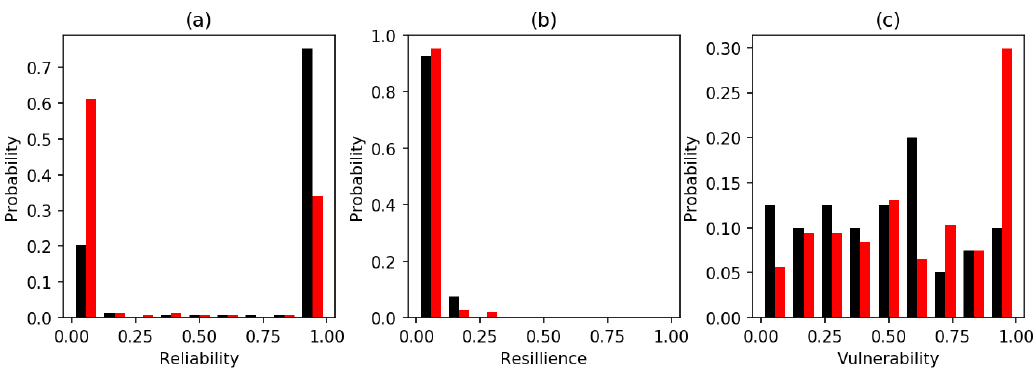
Figure 7. Performance metrics using WUDESIM under nominal (black) and reduced (red) demand scenarios: Distribution of ( a ) reliability; ( b ) resilience; ( c ) vulnerability.